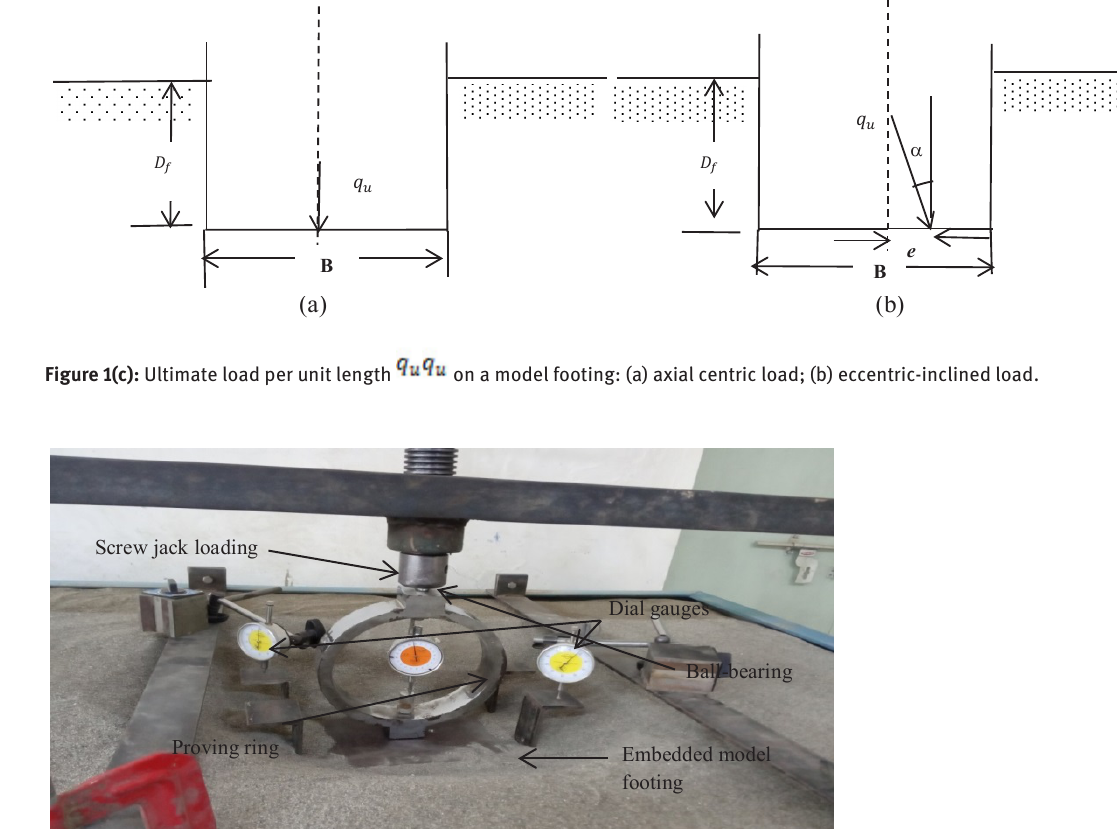
Fig. 2(b) Experimental test setup: (a) horizontal frame; (b) 7 ° inclined frame; (c) 14 ° inclined frame